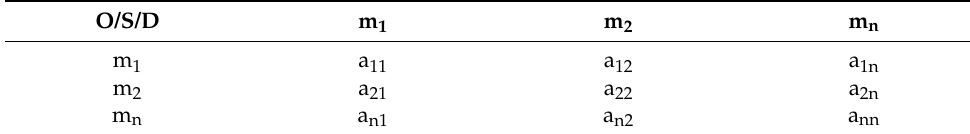
Table 2. Judgment matrix in the case of n